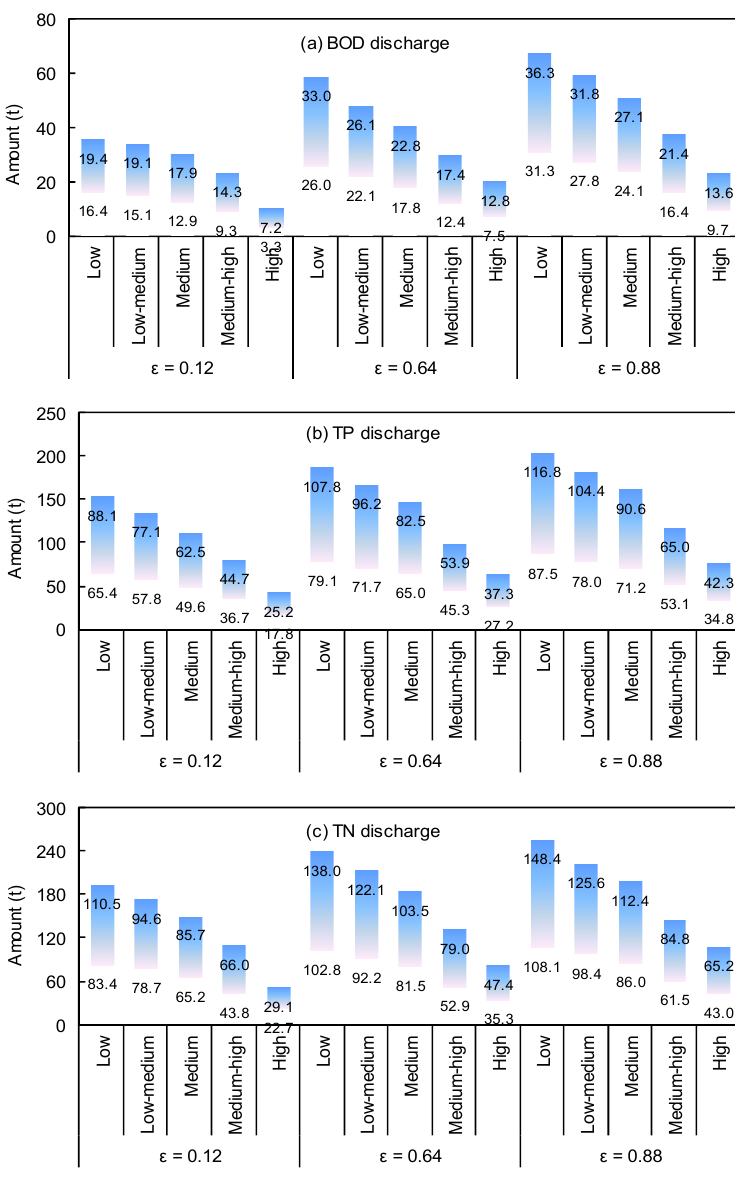
Figure 8. Excess Pollutant Discharge. ( a ) BOD discharge; ( b ) TP discharge and ( c ) TN discharge.